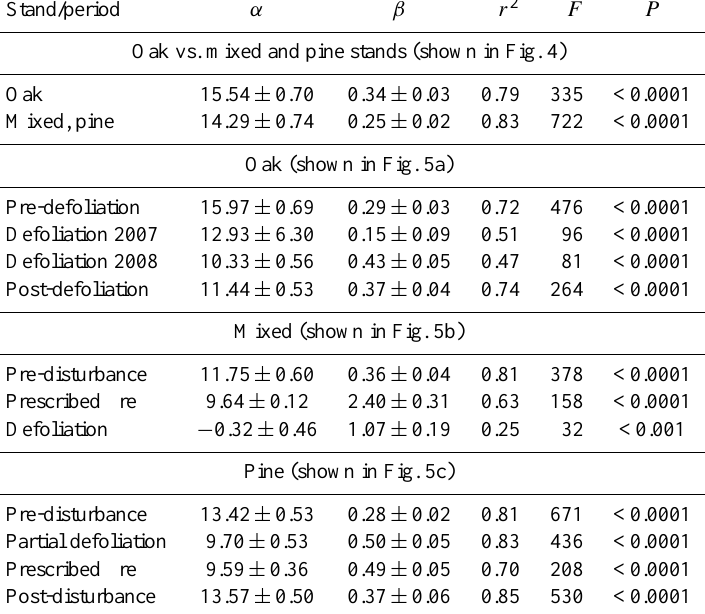
Table 4. Parameter values and statistics for the relationship between daily evapotranspiration and gross ecosystem productivity from 1 June to 31 August for the oak vs. mixed and pine stands in 2005 before disturbance (Fig. 4), the oak stand from 2005 to 2009 (Fig. 5a), the mixed stand from 2005 to 2007 (Fig. 5b), and the pine stand from 2005 to 2009 (Fig. 5c). Data were fitted to GEP = α (1 − exp ( − β (Et))). Parameter values are means ± 1 standard error, r 2 is the value of the Pearson’s product moment coefficient, F is the value of the F statistic, and P is the significance level of the ANOVA analyses for each model.